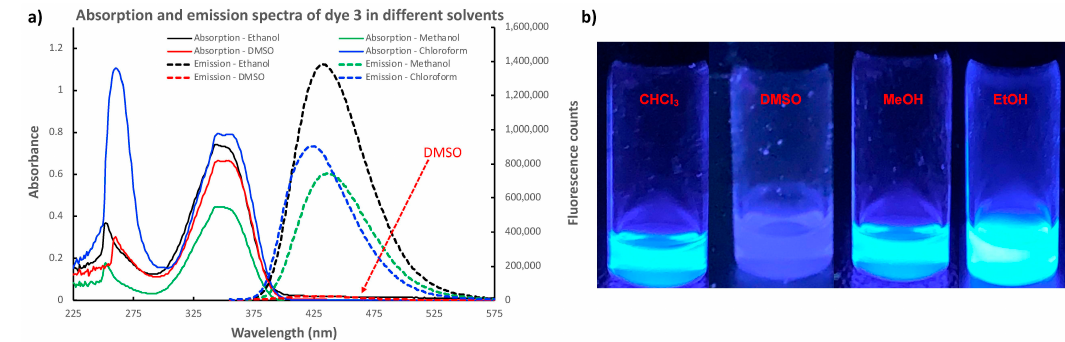
Figure 1. Photophysical properties of 4-phenyl-1,8-naphthalimide. ( a ). Absorption and emission profiles of 4-phenyl-1,8-naphthalimide in chloroform, DMSO, methanol and ethanol. Solid lines: absorption spectra recorded at 100 µ M; dotted line: emission spectra recorded at 10 µ M, excited at 345 nm; ( b ). pictures of 4-phenyl-1,8-naphthalimide in chloroform, DMSO, methanol and ethanol, excited with a handhold UV lamp (360 nm).